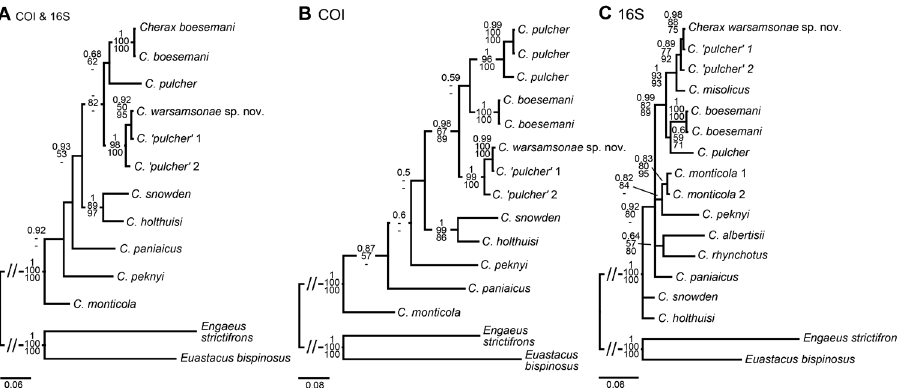
Figure 7. Phylogenetic position of Cherax warsamsonicus sp. n. within closely related New Guinean Cherax species, reconstructed by BI analyses of two mitochondrial gene fragments. Number on branches show, from top, Bayesian posterior probabilities and ML/MP bootstrap values. The scale bar indicates the substitution rate. See Table 1 for information on the sequenced specimens. A Topology based on concatenated COI and 16S dataset B Topology based on COI dataset C Topology based on 16S